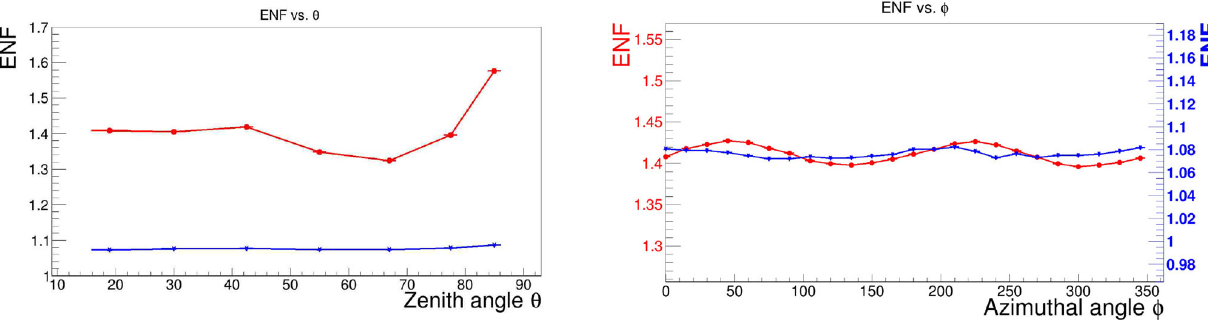
Fig. 37 Uniformity of ENF along the zenith angle ( θ , left) and azimuthal angle ( φ , right). HPK: blue; NNVT: